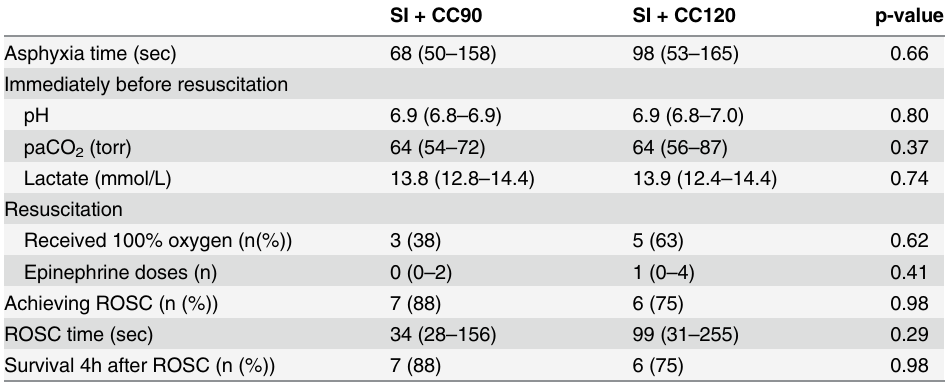
Table 2. Characteristics of asphyxia, resuscitation and survival of asphyxiated piglets (n = 8 in each group)